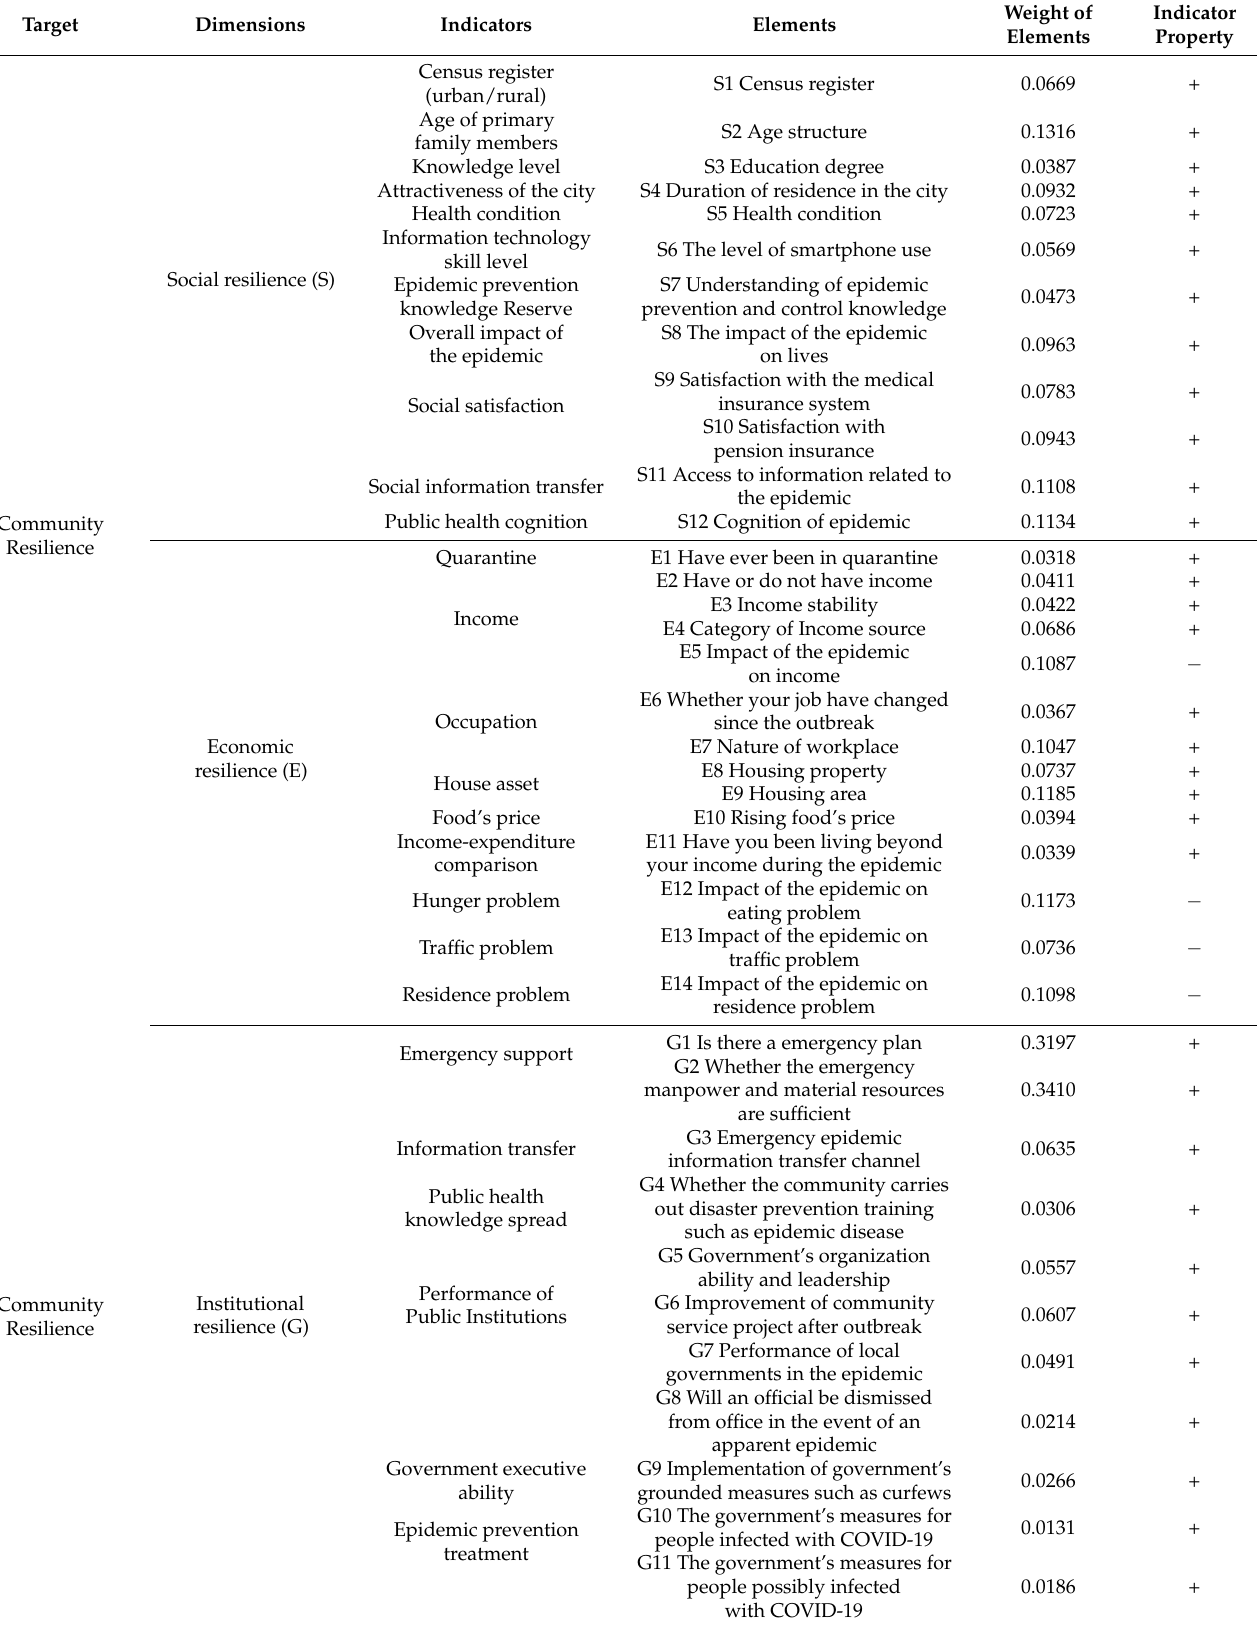
Table 1. Measures of urban community resilience under the COVID-19